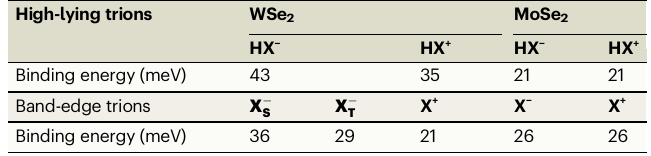
Table 2 | Experimental binding energies of the high-lying trions and band-edge trions in hBN encapsulated monolayer WSe 2 and MoSe